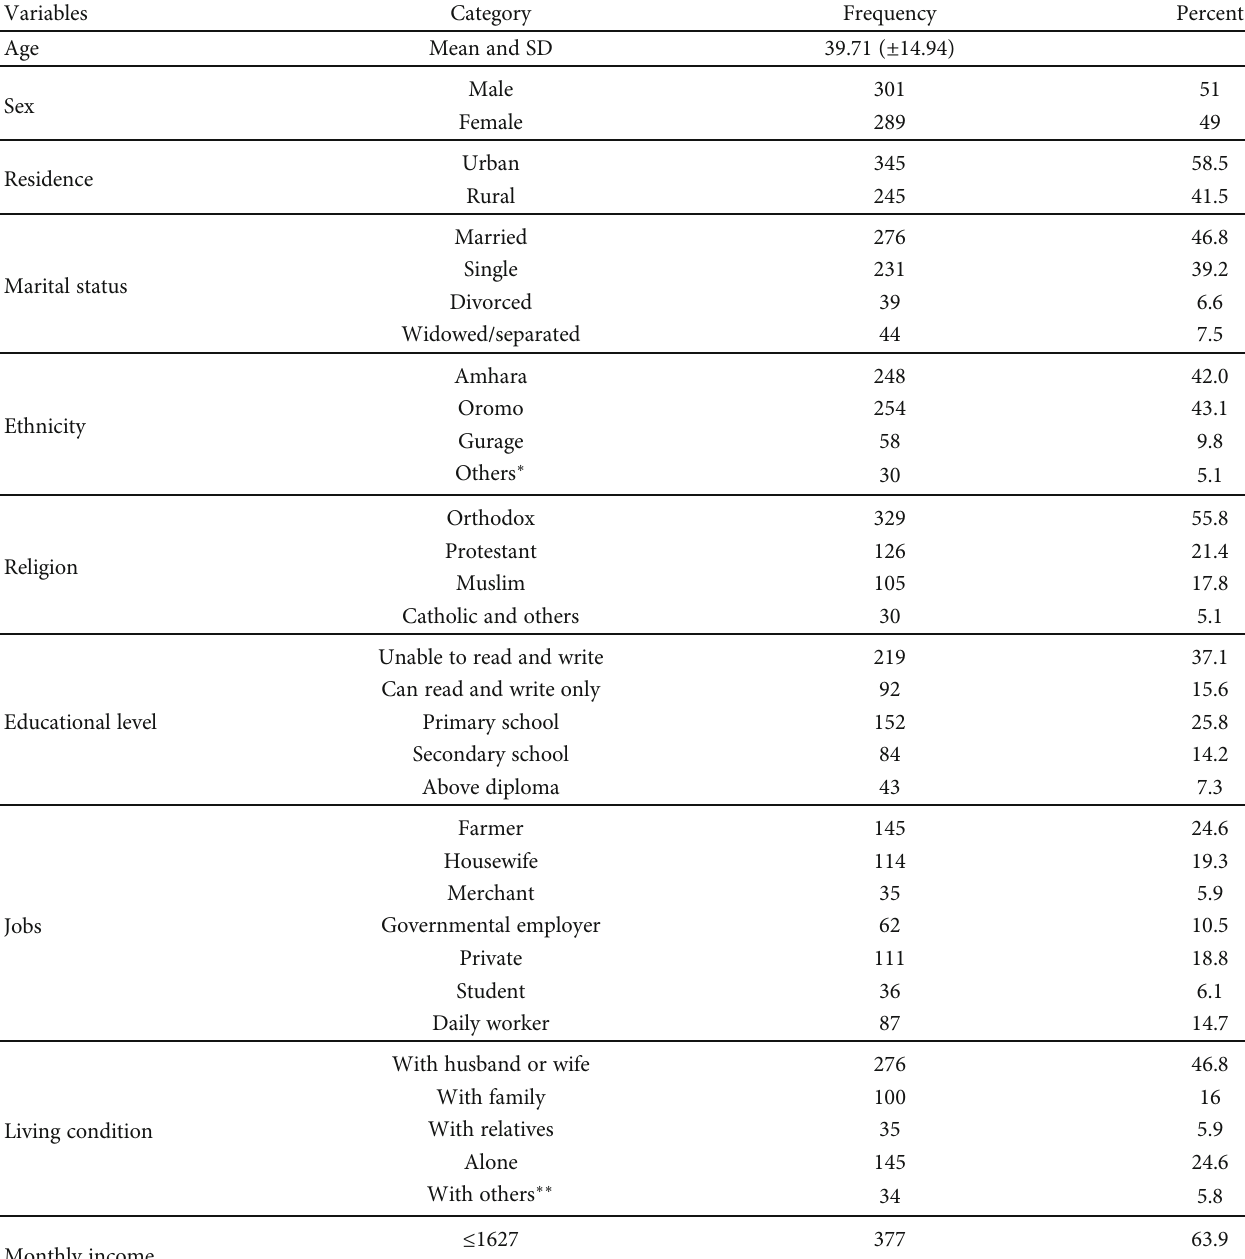
Table 1: Distributions of sociodemographics of participants admitted in medical and surgical wards at SPHMMC, 2019 ( n = 590